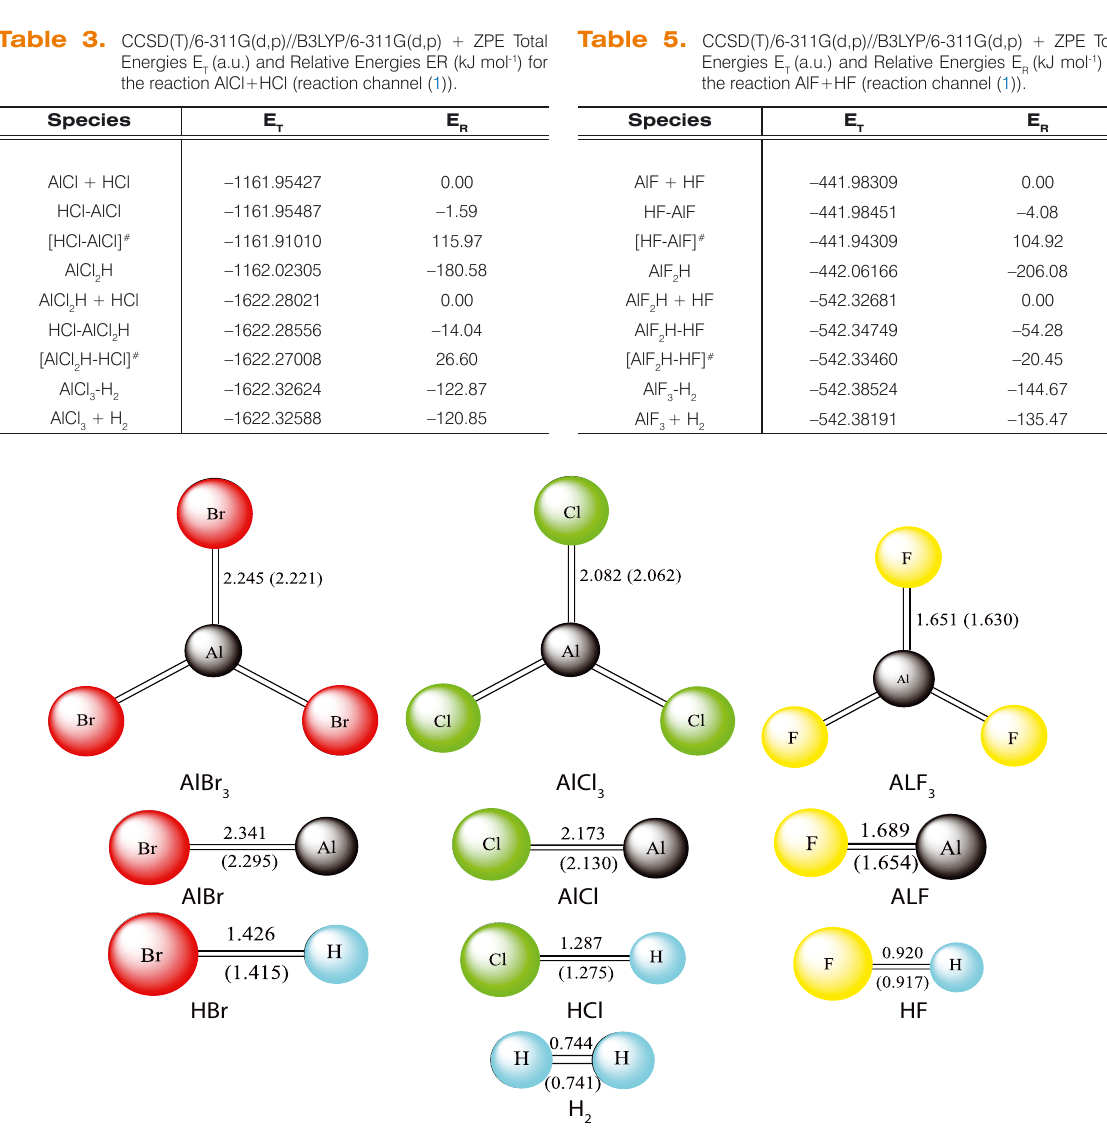
Figure 4. Optimized geometries of reactants and products. Experimental gas phase values are given in parentheses (from [28]). Bond lengths are in Å and bond angles in